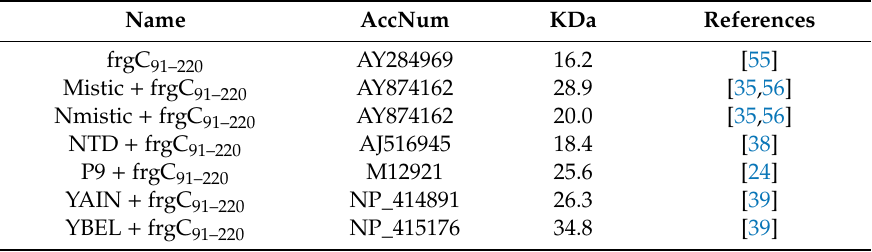
Table 1. Fused to the N -terminus of frgC 91–220 and resulting molecular